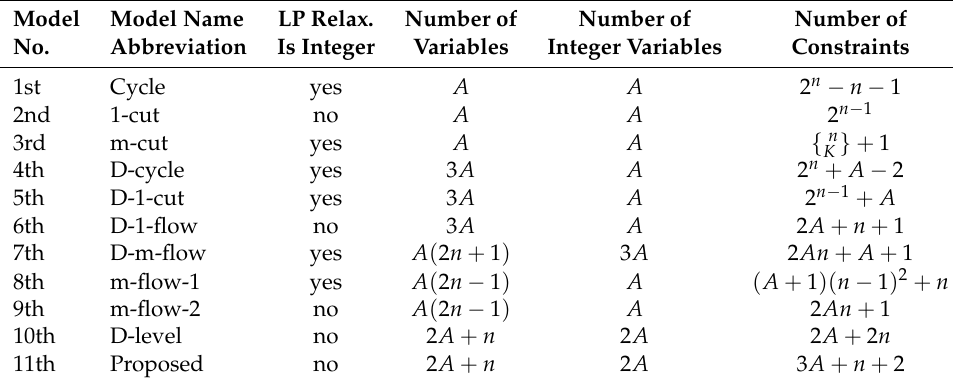
Table 1. Model characteristic and size comparison.